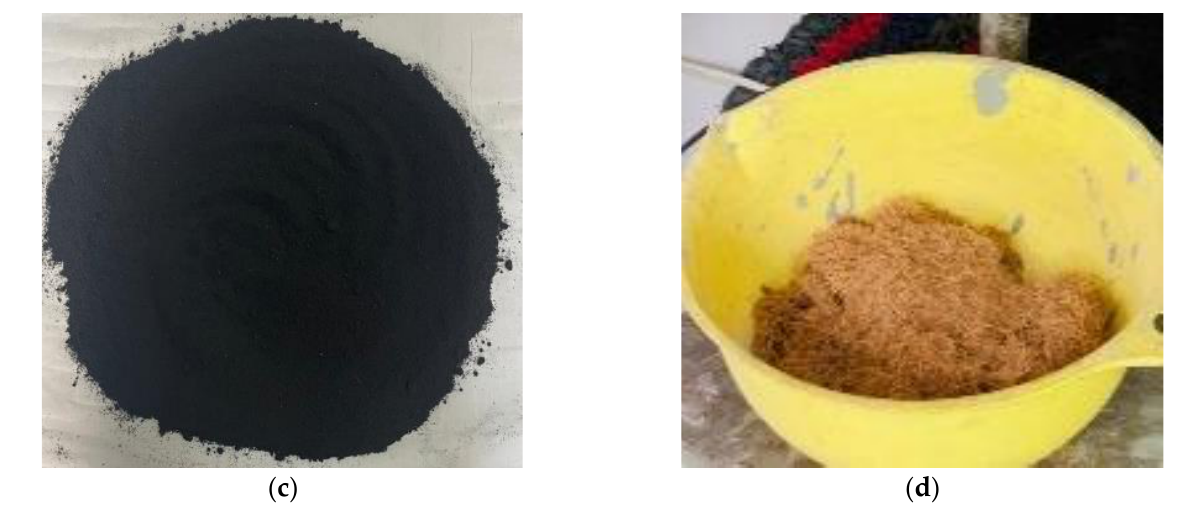
Figure 3. Materials used ( a ) River sand; ( b ) 10/12 mm sized chips; ( c ) CR; ( d ) CCF.